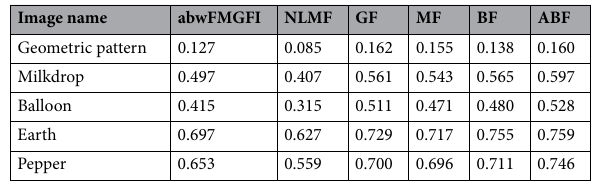
Table 8. Comparison of the SSIM values of each sample image filtered using each filter (against the Gaussian